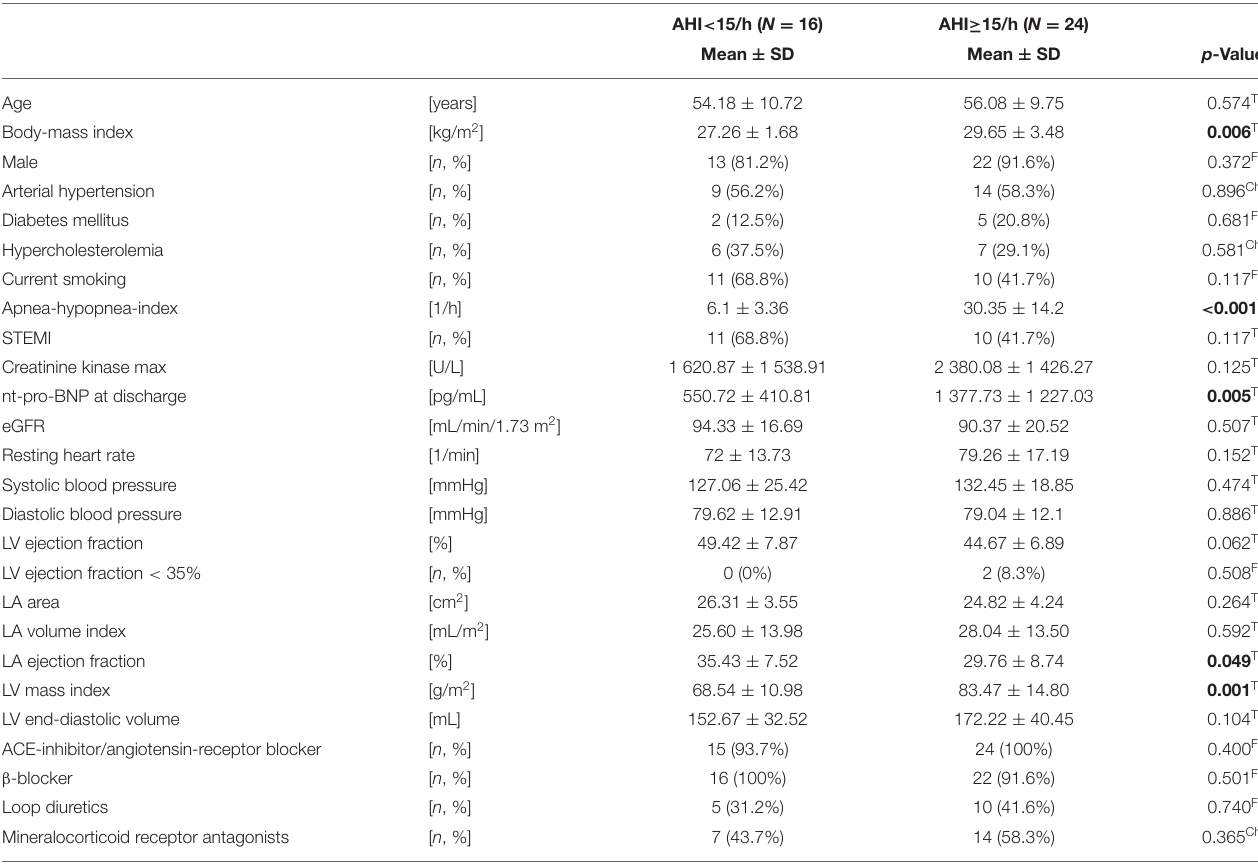
TABLE 1 | Baseline characteristics stratified for patients with and without SDB (AHI >